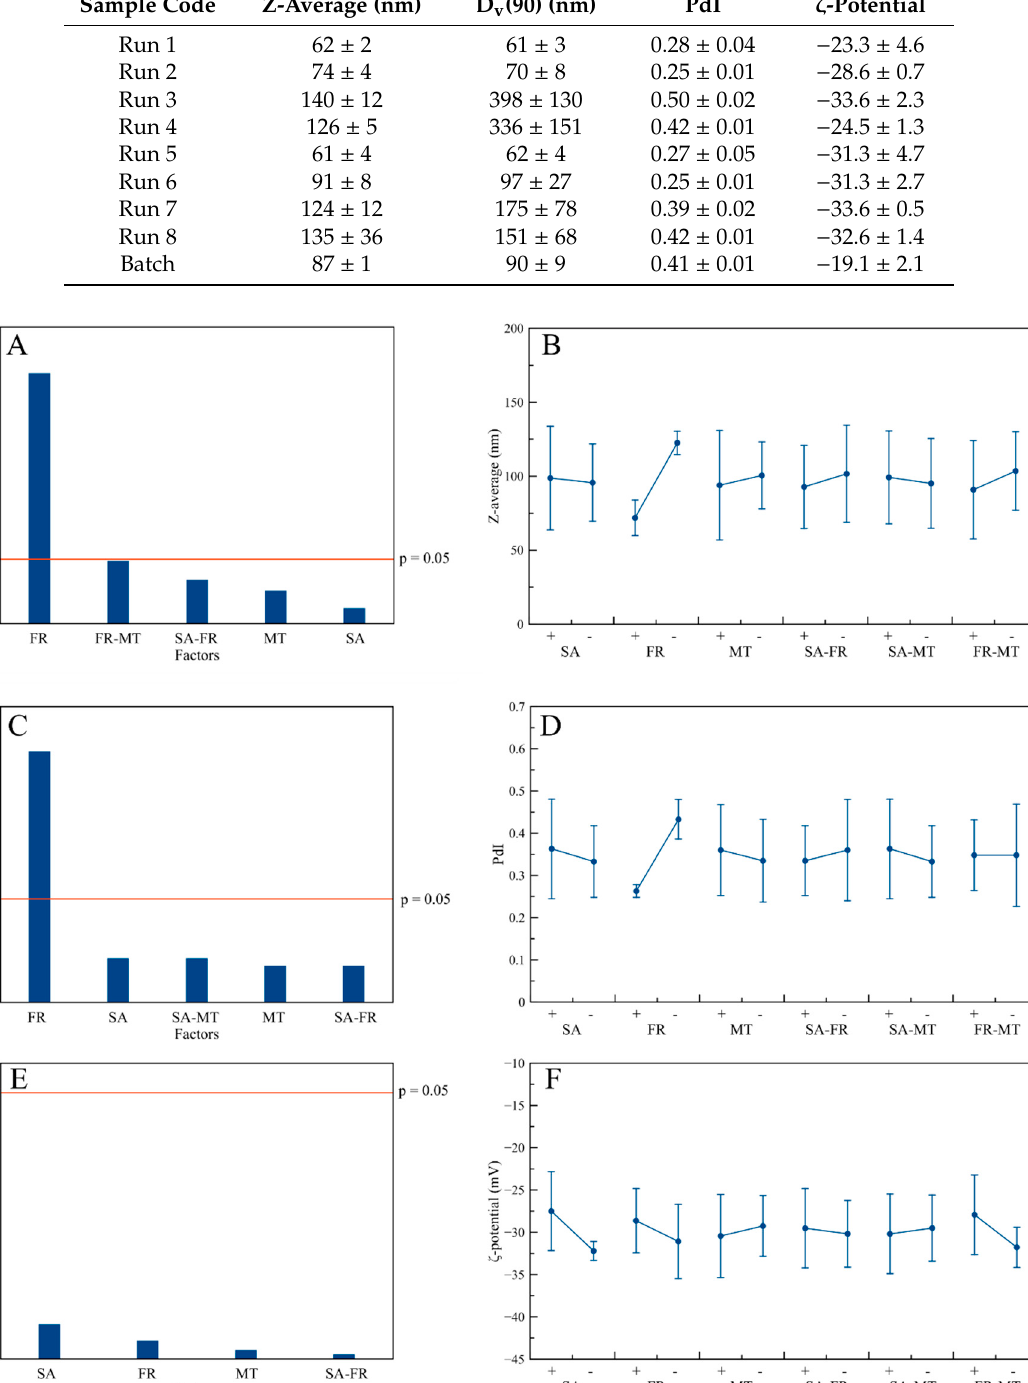
Table 4. Dynamic light scattering (DLS) and electrophoretic mobility analysis of CaP NPs samples.